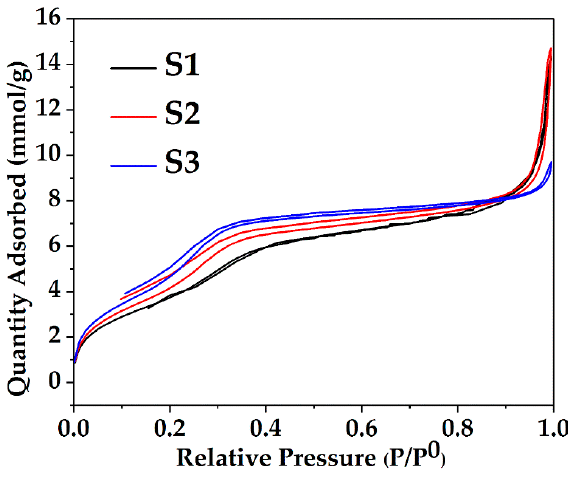
Figure 3. The adsorption/desorption isotherm of the synthesized Ag@SiO 2 particles.